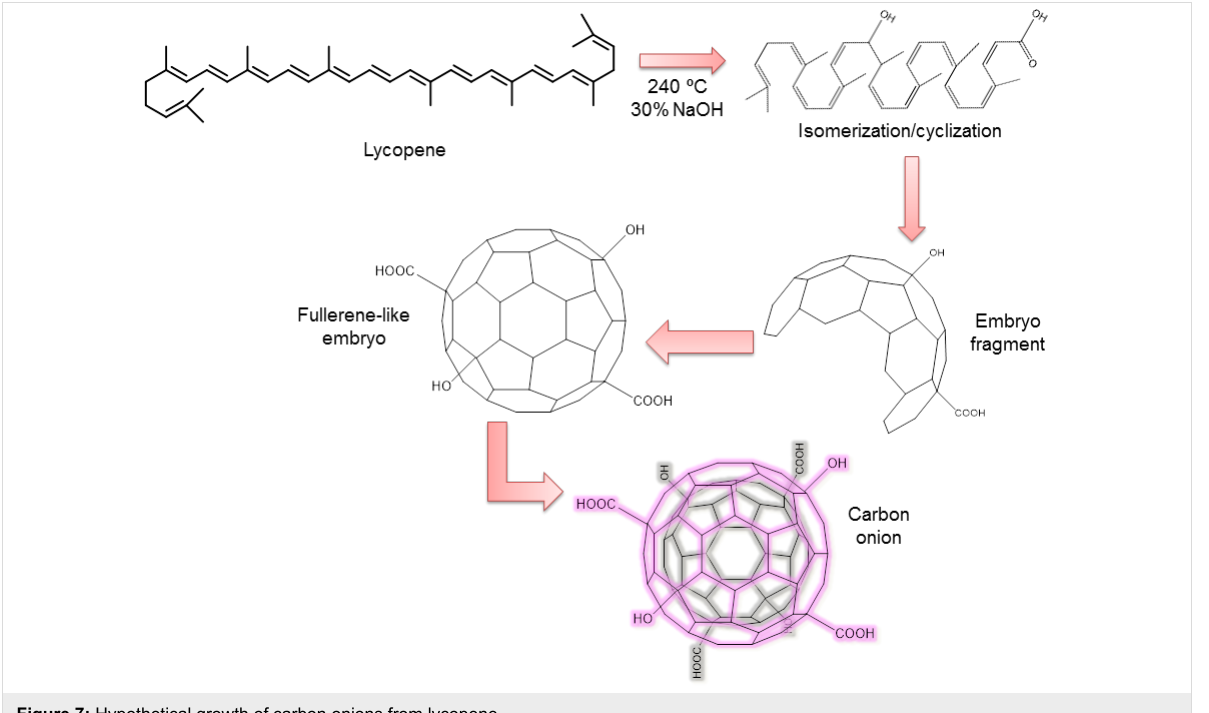
Figure 7: Hypothetical growth of carbon onions from